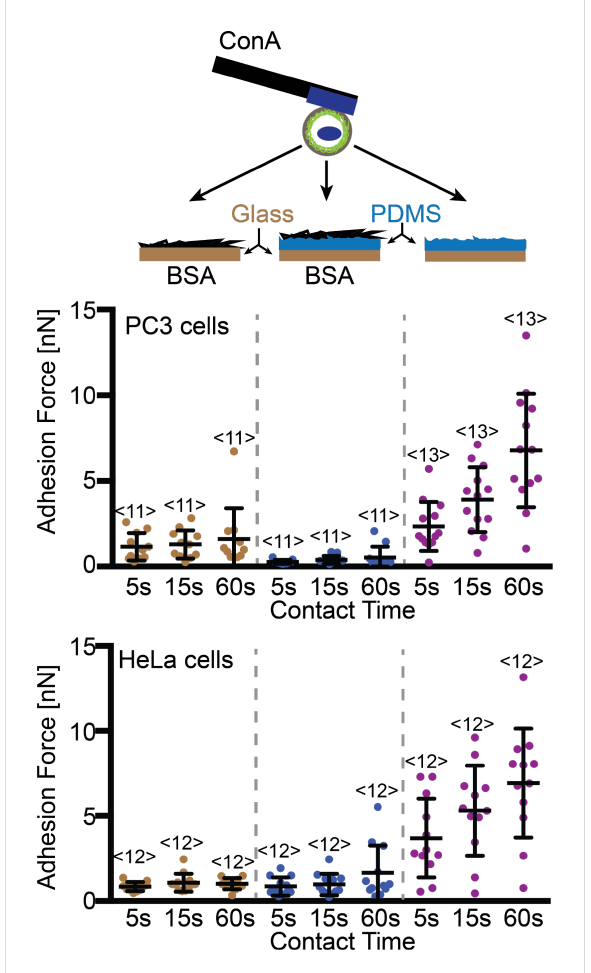
Figure 4: Comparisons of glass-surface and PDMS-surface masks . Top, depiction of the SCFS assay used to quantify the adhesion of PC3 and HeLa cells. Single cells were bound to ConA-coated cantilevers and approached BSA-coated glass or PDMS and a clean PDMS surface until a force of 2 nN was recorded. After the denoted contact time, the cantilever was retracted to detach the cantilever- bound cell and substrate. During retraction, the adhesion force of cell and substrate was measured. Bottom: adhesion forces recorded for PC3 and HeLa cells during their detachment from substrates. Each dot represents the measurement of one cell with the number of cells assayed for each condition given by < n > The x -axis indicates the dura- tion (5, 15 and 60 s) that the cell was in contact with the substrate before being detached. The error bars indicate mean force and stan- dard